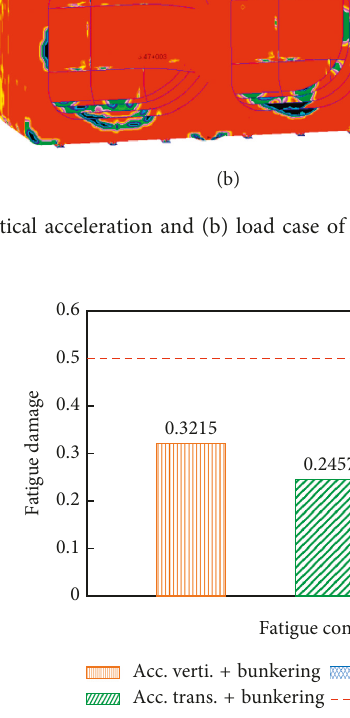
Figure 17: Calculated total fatigue damages and fatigue damage criterion.